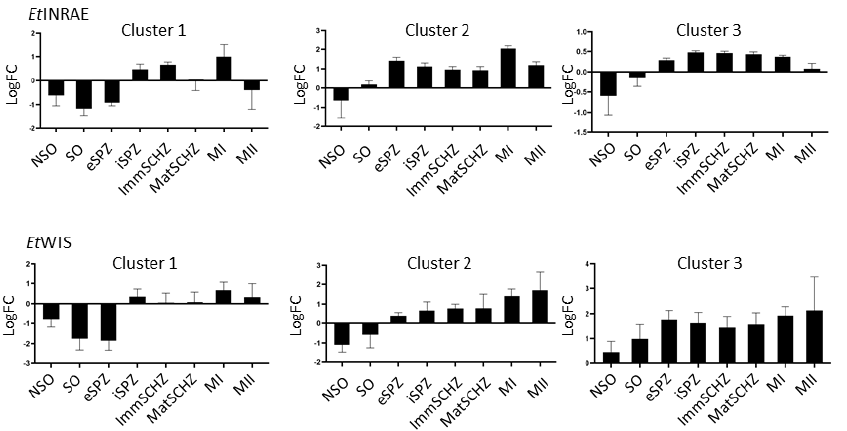
Figure 5. Expression profile clustering of the rhoptry kinases in different stages of development of Eimeria tenella . Histograms show log fold change (Log FC) in the stage of development vs. gamete stage; Etactin and Et18s served as housekeeping genes.